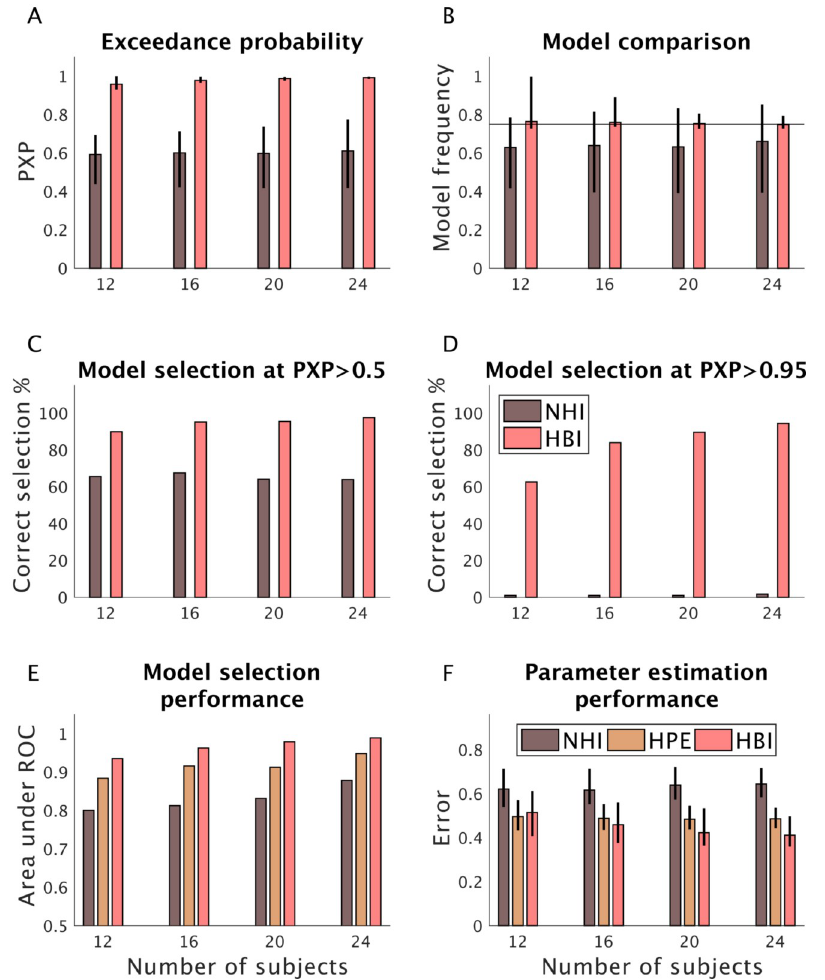
Fig 6. Performance of the HBI as a function of the number of subjects. In this analysis, simulations were repeated 1000 times, in which in half of the simulations, the ratio of the RL model was three times more than the dual- α RL, and vice versa in the other half. A) Protected exceedance probabilities (PXP) of the most frequent model estimated by the HBI and NHI; B) Model frequency of the most frequent model across all simulations. The black line indicates the true frequency (0.75). C-D) Model selection performance by the HBI and NHI at PXP > 0.5 and PXP > 0.95, respectively. The NHI almost never selects the most frequent model at PXP > 0.95. E) Model selection performance using area under the ROC curve. Higher values indicate better performance (one corresponds to perfect model selection). The HBI performance improves by increasing the number of subjects. F) Error in estimating individual parameters across both models and parameters. Estimation errors are computed on the normally distributed parameters. The estimation error is defined as the absolute difference between estimated parameters and the true parameters. In A, B, and F, median across 1000 simulations is plotted and error-bars represent the first and third